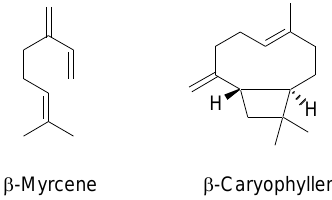
Figure 3. Chemical structures of main terpenes in hemp inflorescences .